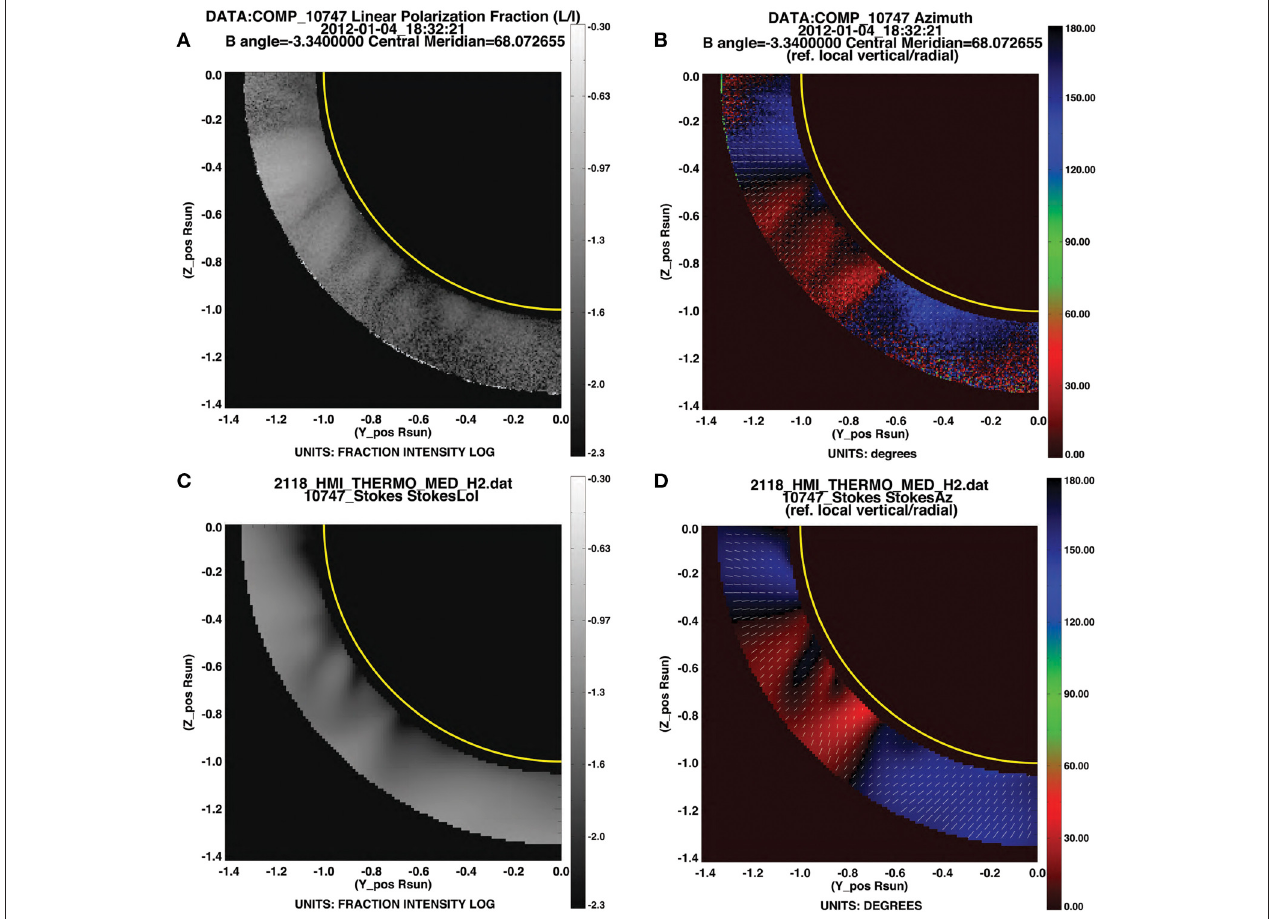
FIGURE 12 | Linear polarization: observations vs. model (A–D) as in Figure 11, but zoomed in to southeast quadrant (keywords set: xxmax=0.,yymax=0 ).